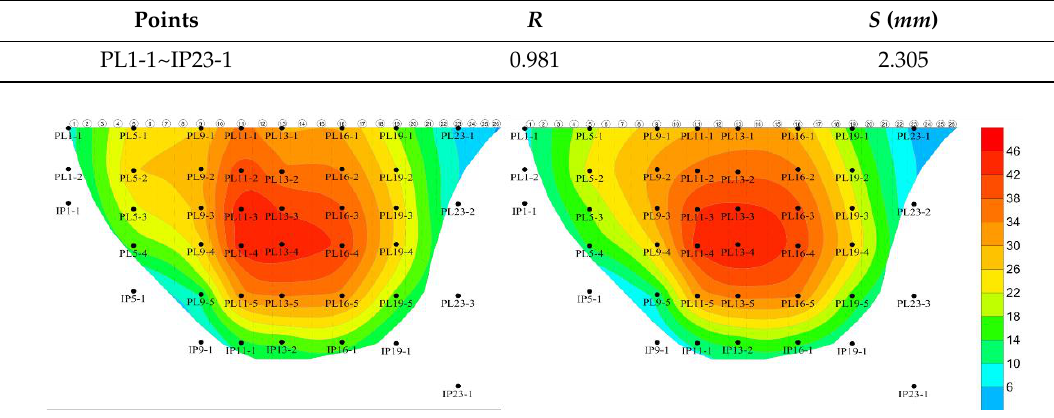
Figure 18. Comparison nephogram between the measured value ( Left ) and calculated value ( Right ) of spatiotemporal hybrid model of radial displacement of dam body on 31 December 2018 (unit: mm).